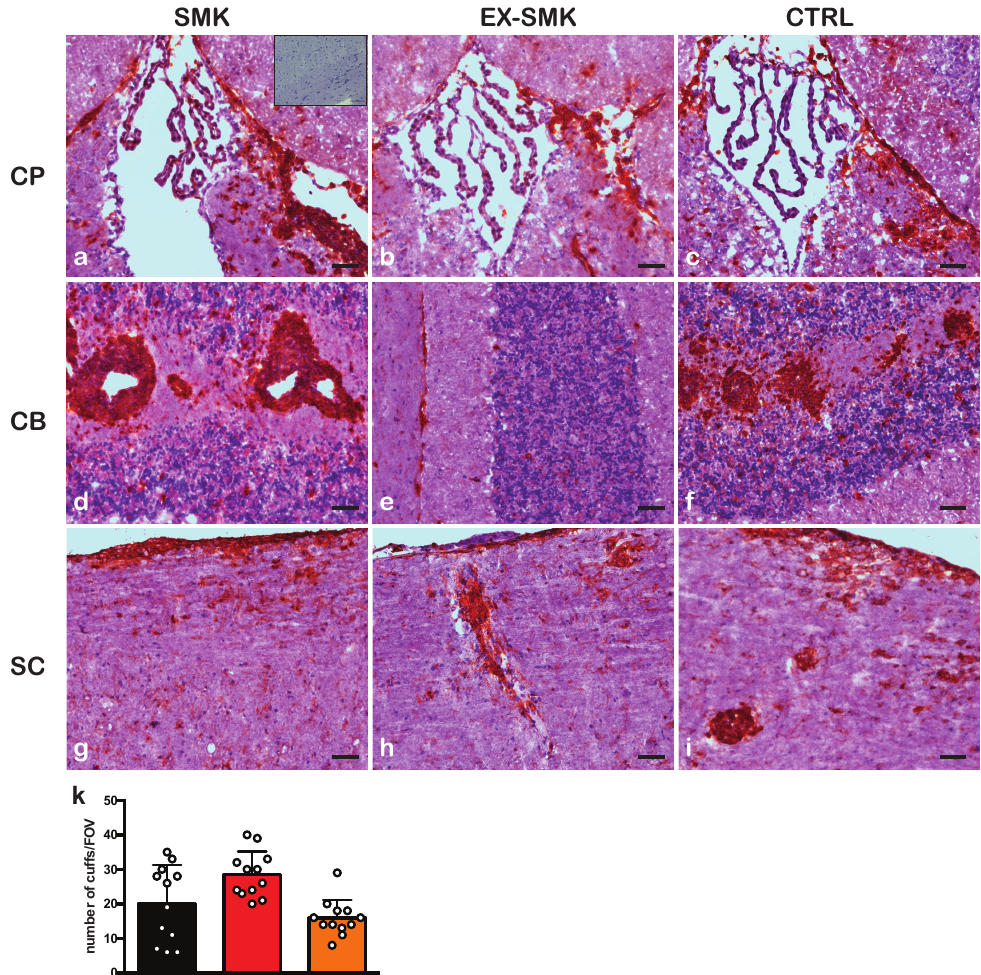
Figure 5. Comparable CNS localization and accumulation of CD45 + inflammatory cells between SMK, EX-SMK, and CTRL groups in SJL mice subjected to aEAE. Immunohistochemical staining for CD45 + leukocytes in the vicinity of the choroid plexus (CP) of the 3rd ventricle ( a – c ), the cerebellum (CB) ( d – f ), and the spinal cord (SC) ( g – i ) of SJL/J mice (day 31 post immunization, clinical score 1) is shown. Quantitative analysis of the cerebellar infiltrate ( k ) demonstrated more and bigger inflammatory cuffs in the cerebellum of the SMK versus the EX-SMK and CTRL group. Differences were not significant. Sections were counterstained with hematoxylin. A negative staining control employing an isotype-matched antibody is shown as inset in panel a. The scale bars are 100 µ m.